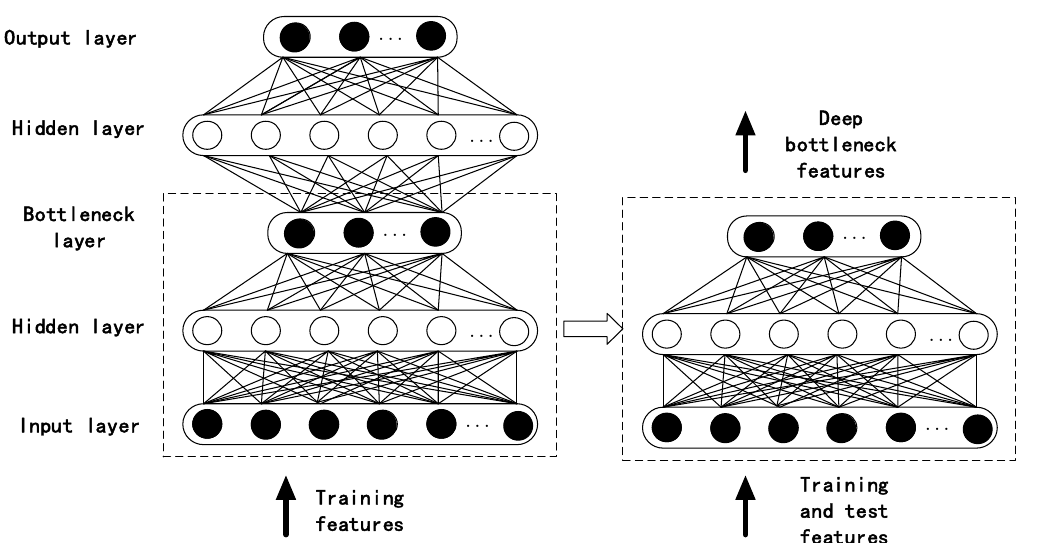
Figure 3. Deep Neural Network (DNN) model for extracting deep bottleneck features. After the deep bottleneck features are obtained, we use them as the input of GMM to get the Gaussian mean vector. Since there are some correlations between the Gaussian mean vectors of different frames, we further recombine these vectors according to